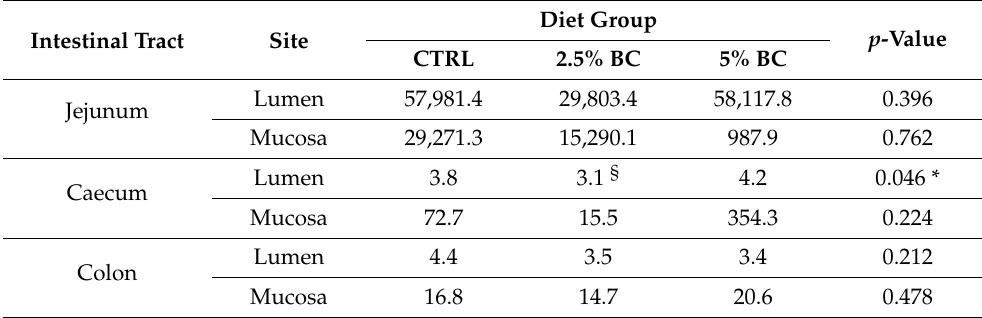
Table 3. Average Firmicutes:Bacteroidetes ratio for the three diet groups (CTRL, 2.5% BC, and 5% BC) divided per intestinal tract and tissue. The p -value is that of a Kruskal–Wallis test; “*” indicates statistical significance ( p < 0.05). In Diet groups, a significant difference from the CTRL diet (Dunn’s post hoc pairwise test, p < 0.05) is indicated by a